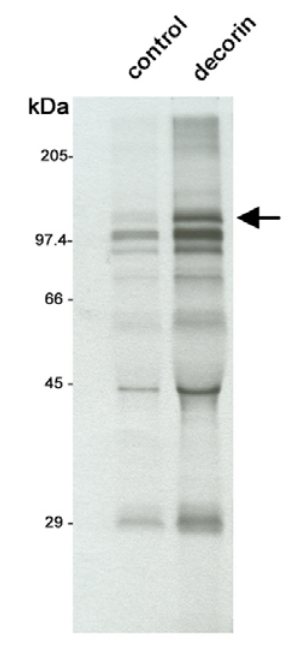
FIGURE 6 . SDS-PAGE autoradiography of cross-linked decorin-receptor complexes immunoprecipitated from [ 35 S]- methionine-labeled fibroblasts. Human skin fibroblasts were steady-state labeled with [ 35 S]-methionine and subjected to endocytosis of SASD-conjugated decorin as described in the legend of Fig. 5. Decorin-receptor complexes were immunoprecipitated from DEAE-purified cell extracts. Immunoprecipitates from control preimmune serum (control)